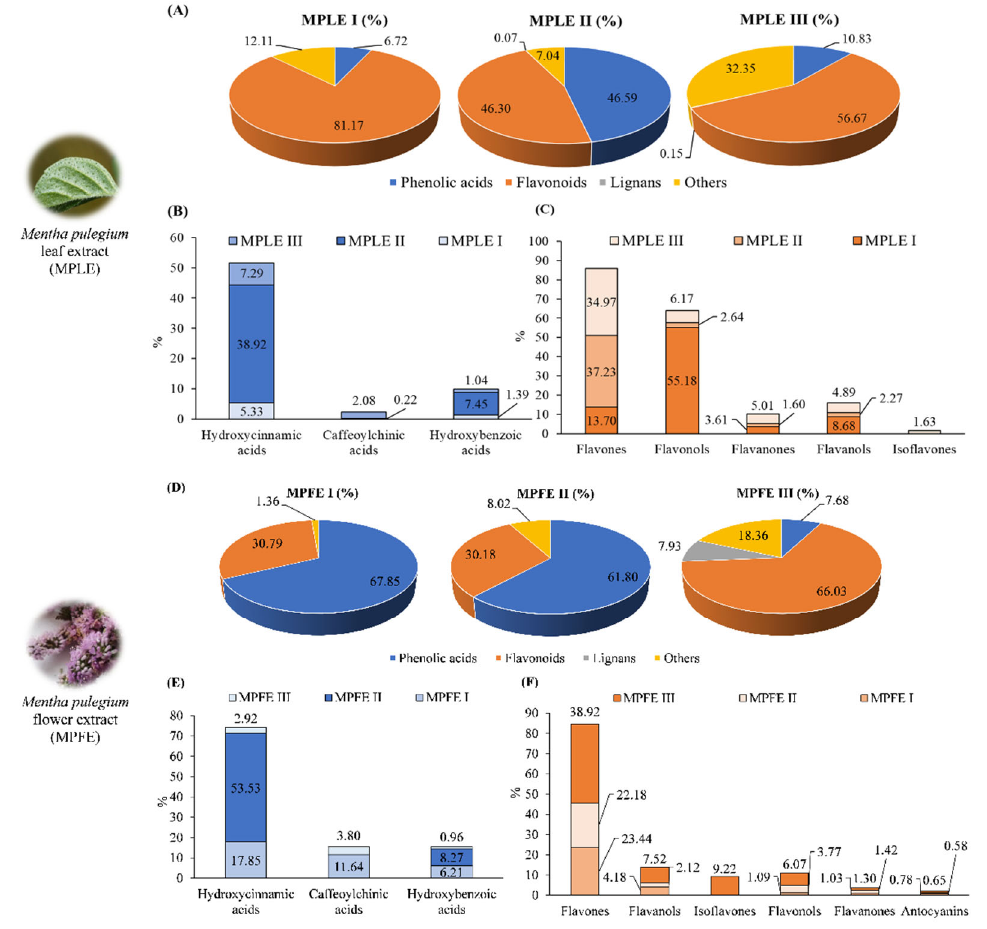
Figure 4. Comparison of the mean percentage (%) distribution of the different classes of polyphenols identified in the extracts of leaves ( A – C ) and flowers ( D – F ) of M. pulegium (MPLE and MPFE, respectively). Results are expressed as mean area percentage (%) based on LC-DAD data acquired at 280 nm with respect to the total area of identified and unidentified (unknown) compounds.